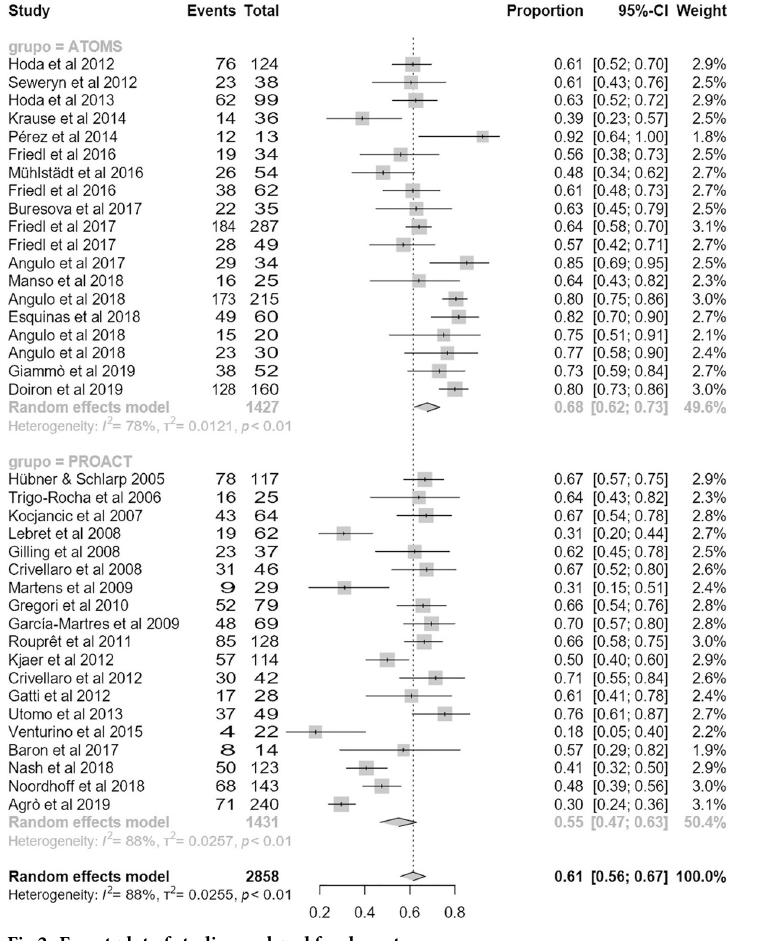
Fig 2. Forest plot of studies analyzed for dry